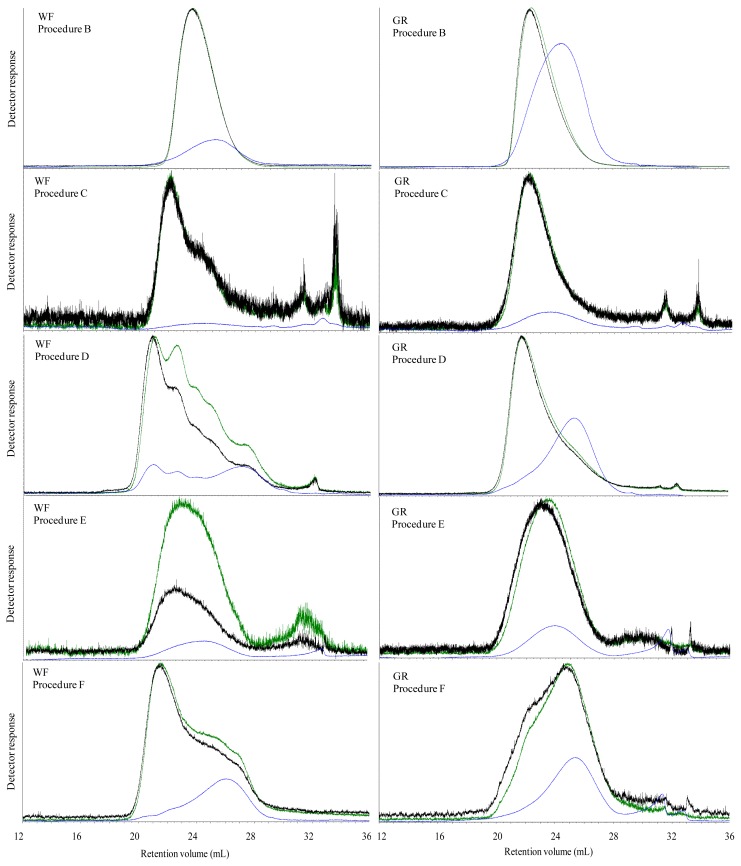
Size exclusion chromatography with RALLS (green), LALLS (black) and intrinsic viscosity (blue) signal of extracts of water extracted (procedure B), in vitro digested (procedure C), in vivo digested (procedure D) and lichenase treated in vitro digested (procedure E) and lichenase treated in vivo digested (procedure F) WF and GR breads.